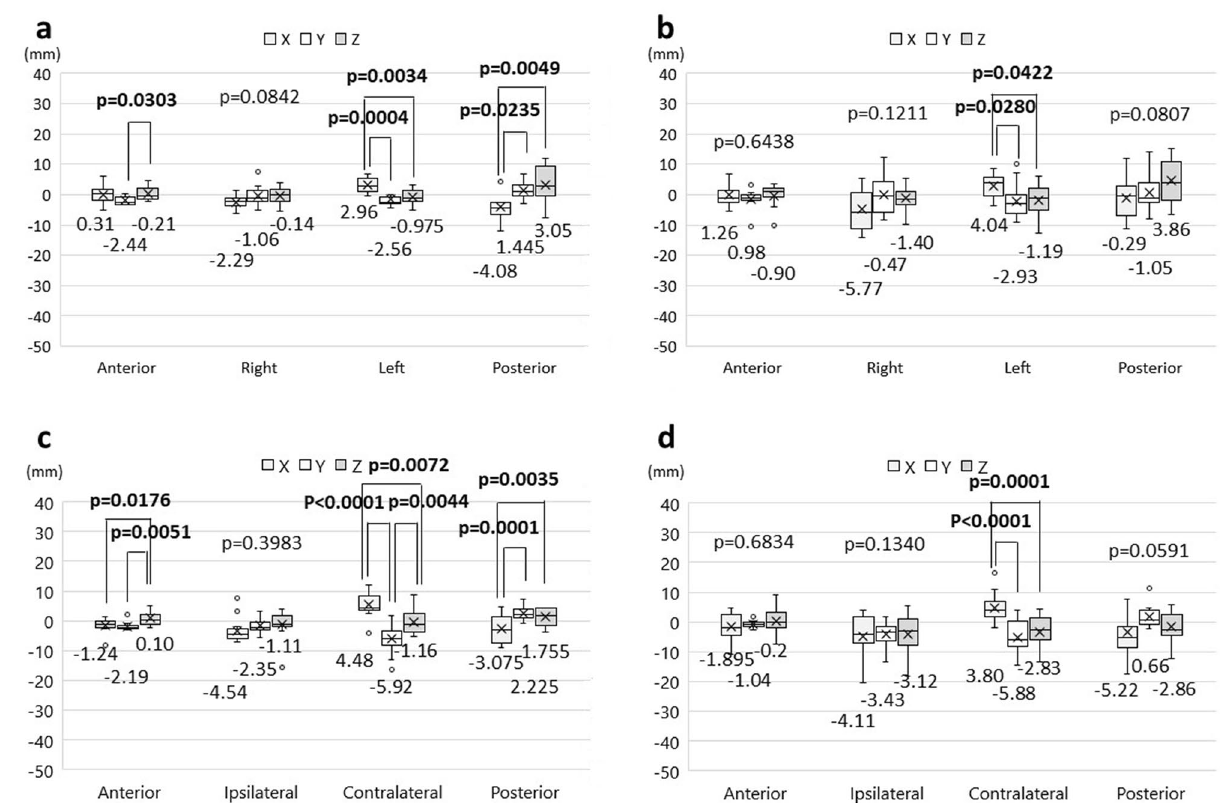
Figure 5. The direction of the distance errors for each fiducial marker in the supine position without and with head rotation. Box plots show the values of the distance errors in the xyz-components of each marker. ( a) automatic intraoperative registration in the supine position; ( b) surface-merge registration in the supine position; ( c ) automatic intraoperative registration in the supine position with head rotation; ( d ) surface-merge registration in the supine position with head